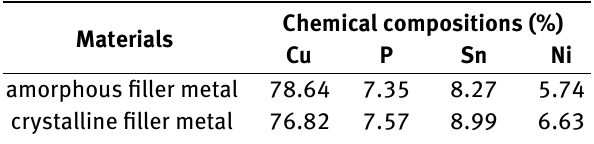
Table 1: Chemical composition of filler metal